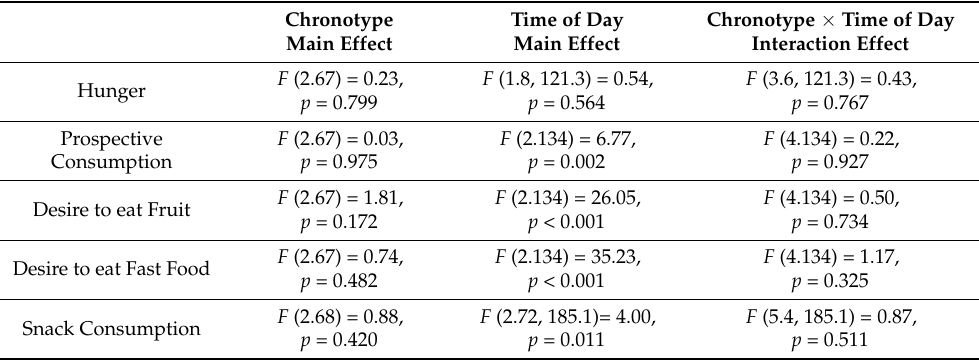
Table 1. Chronotype and time of day main and interaction effects on hunger, prospective consump- tion, desire to eat fruit, desire to eat fast food, and snack consumption before, during, and immediately after a simulated night